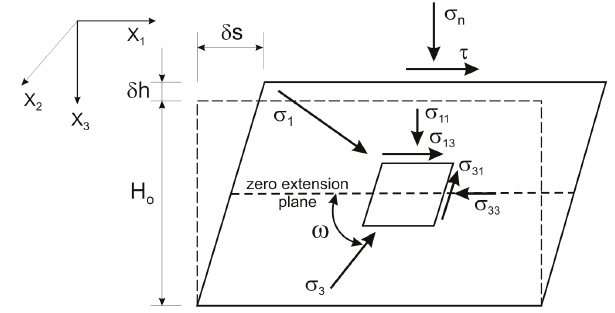
Fig. 1. Geometry, stress and strain in simple shear